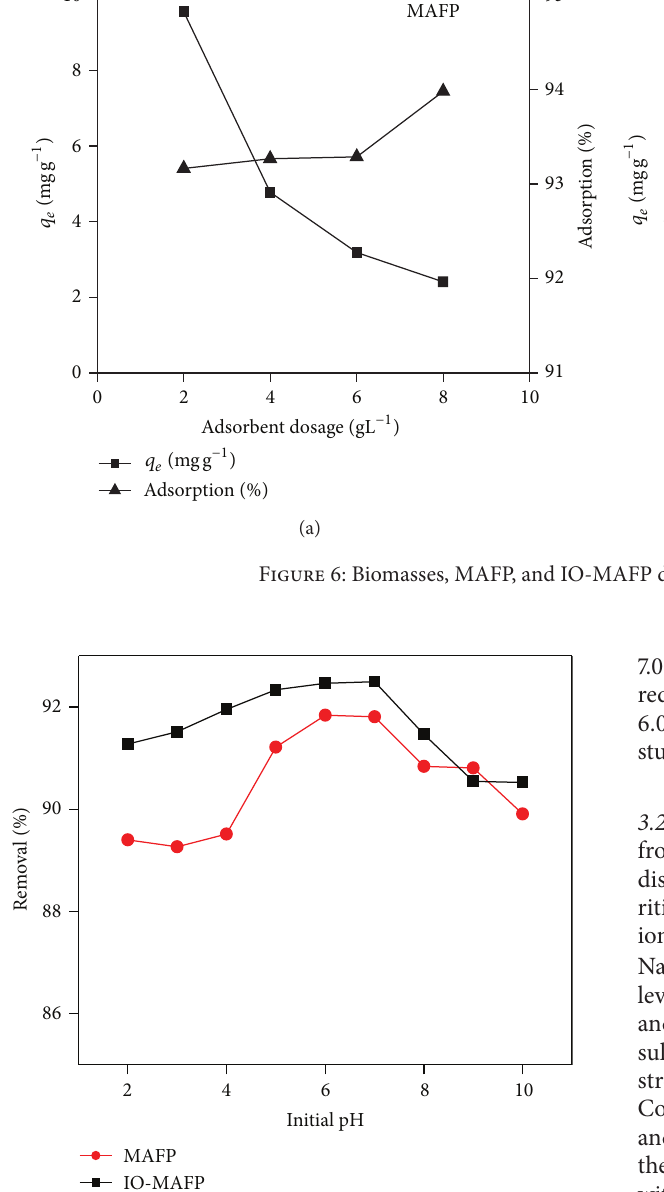
Figure 7: Evaluation of pH effect on sorption of Co(II) onto MAFP and IO-MAFP